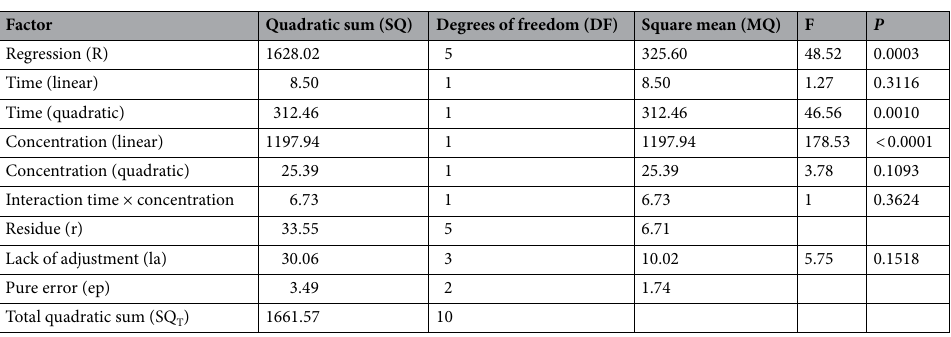
Table 3. ANOVA for the results statistical treatment related to the planning for obtaining extracts by Soxhlet in aqueous solvent.